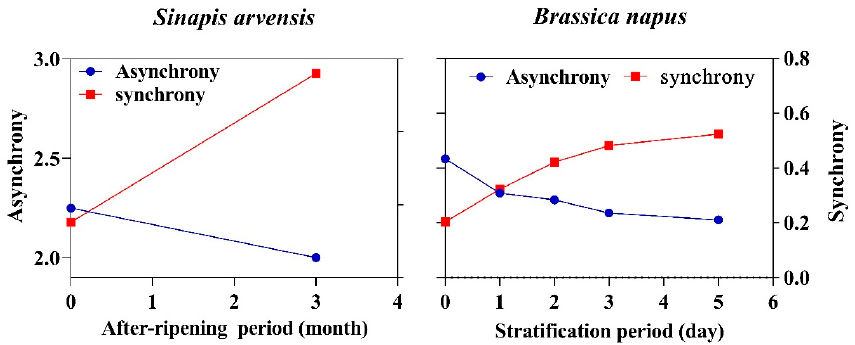
Figure 1. The changes in synchrony and asynchrony patterns in response to after-ripening and strat- ification